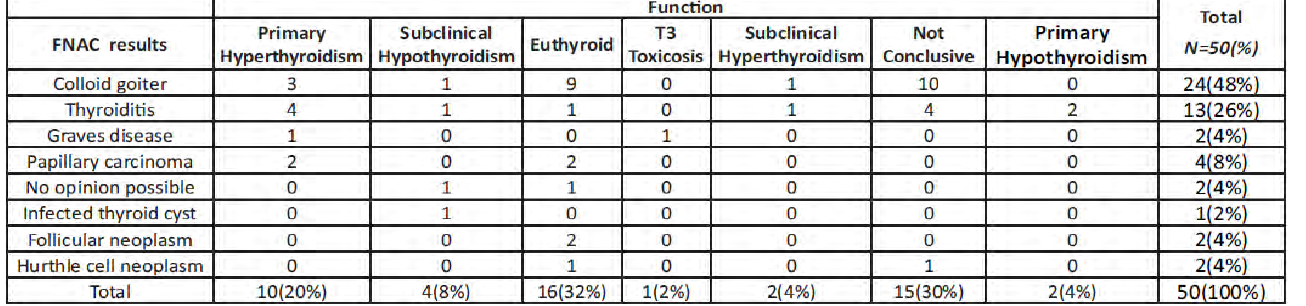
Table 4: cross tabulation between FNAC and